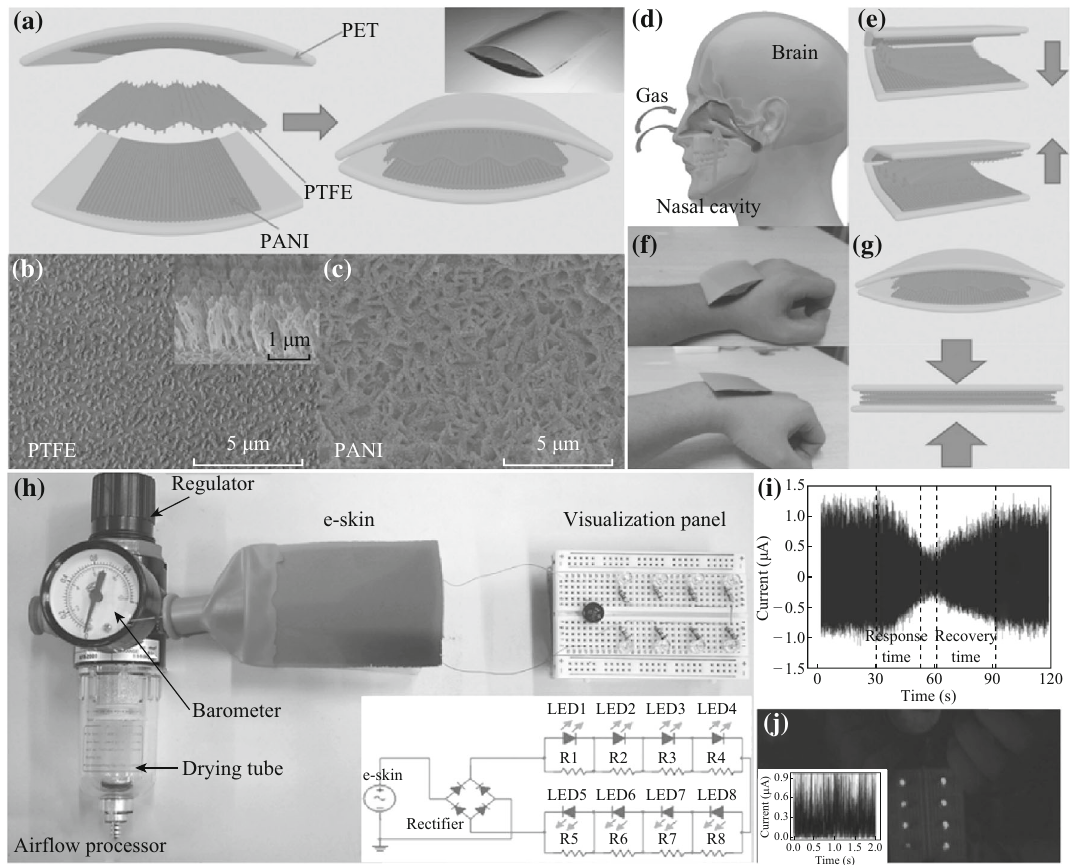
Fig. 10 Outputting olfactory bionic electric impulse by PANI/PTFE/PANI sandwich nanostructures and their application as flexible, smelling electronic skin. a Structure and fabrication process of the flexible smelling e-skin (the inset shows the photograph of the e-skin). b SEM image of PTFE nanostructures on the top view (the inset shows cross-sectional SEM image of PTFE NWs). c SEM image of PANI nanostructures on the top view . d and e The e-skin can be easily driven by gas flow (human heavy breath or blowing). f , g The e-skin can be easily driven by body motion (pressure). h Photograph of the self-powered breath–alcohol visual detecting system. i Real-time continuous responding/recovering process of the e-skin against 210 ppm ethanol gas flow. j An adult without drinking alcohol can light 8 LEDs. Figures adapted from